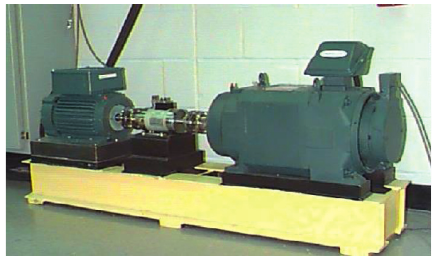
Figure 7: Experiment rig of the rolling